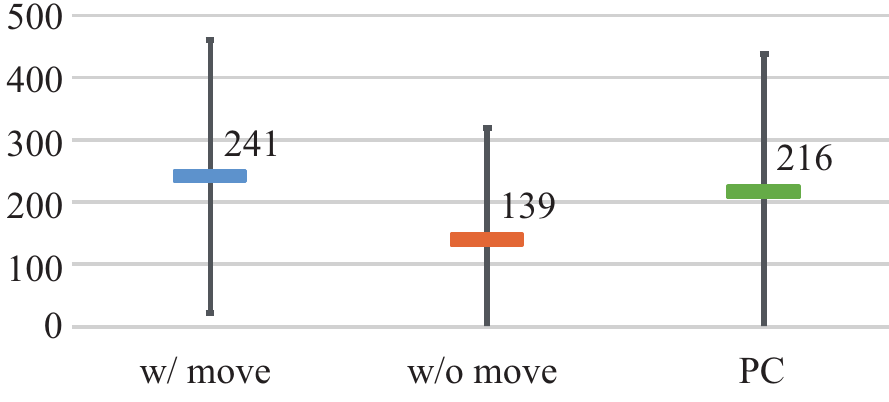
Figure 16. Average of the moving variance of yaw-axis data (zoo).